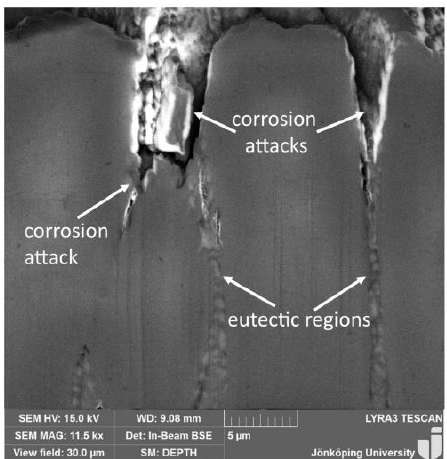
Figure 15. FIB-SEM micrograph of the corroded area in cross-section taken from the anodized sample by liquid casting. Reprinted with permission of [98].